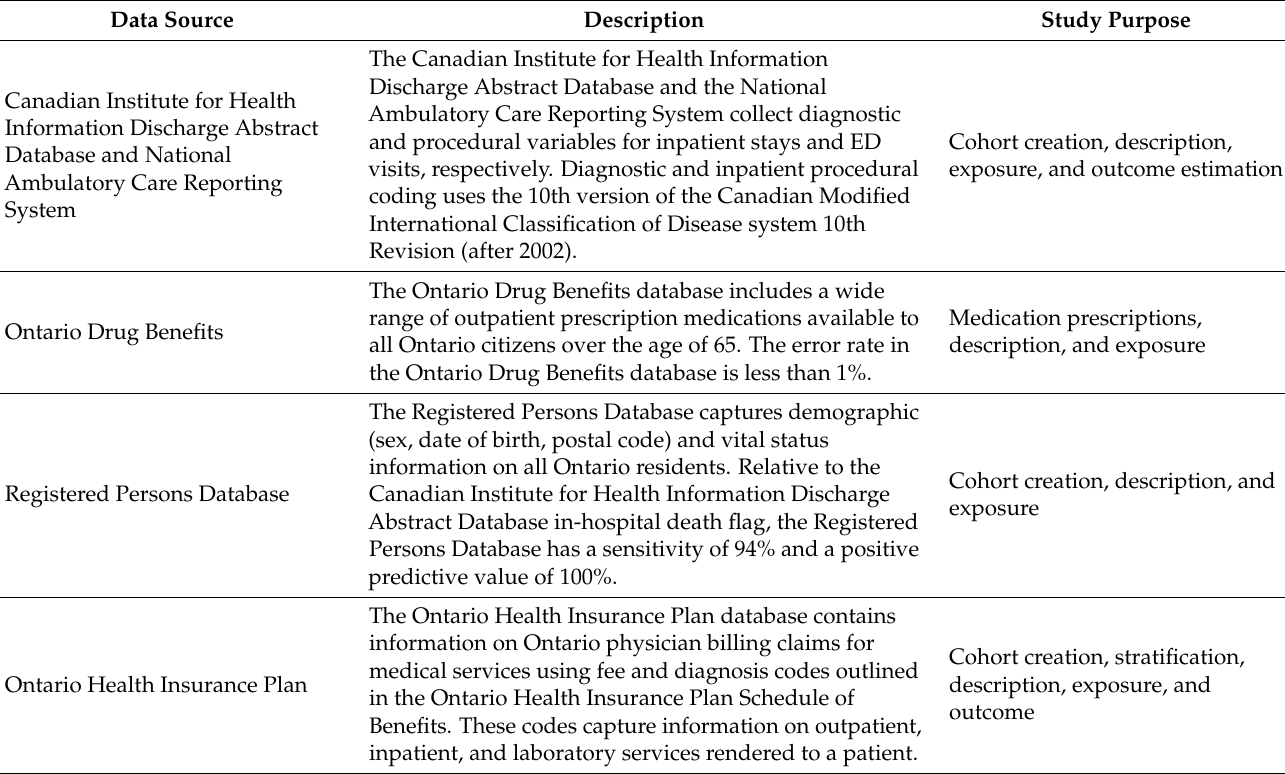
Table A1. List of databases held at ICES (an independent, non-profit, world-leading research organization that uses population-based health and social data to produce knowledge on a broad range of healthcare issues).